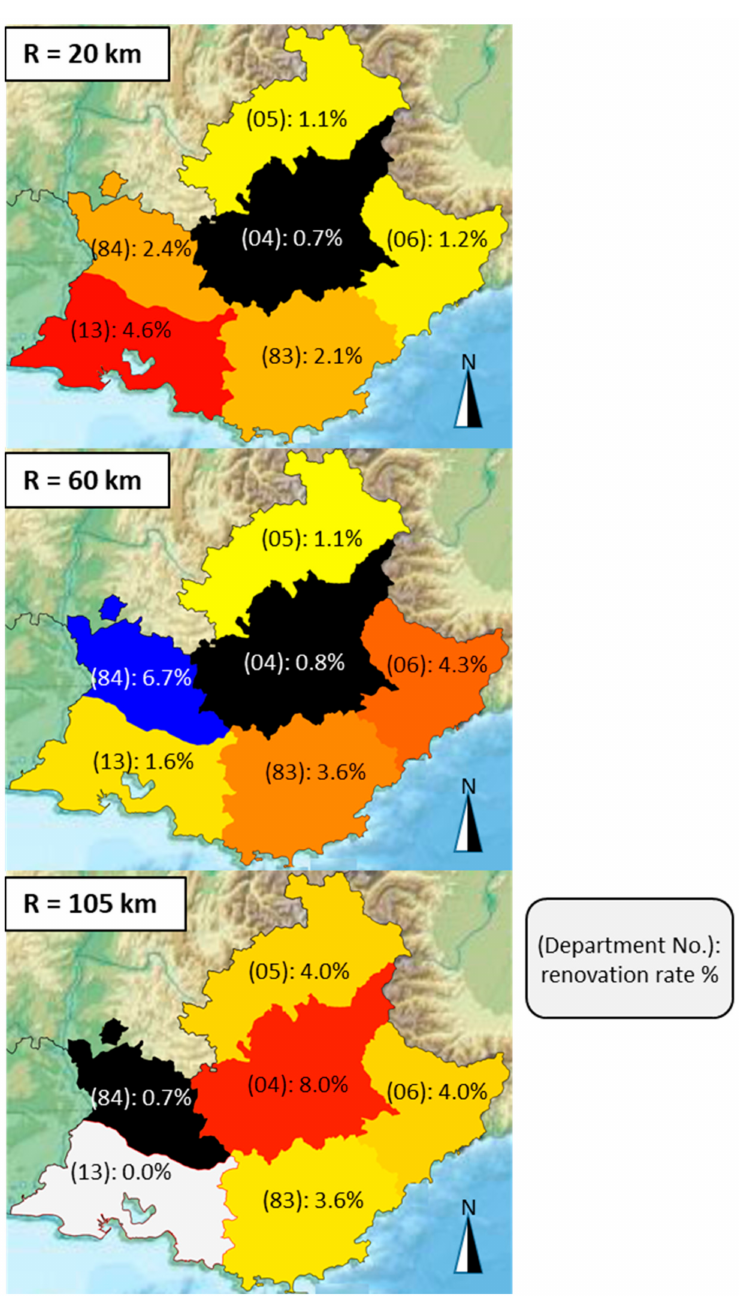
Figure 7. Distribution hypotheses for the renovation rate of each Department as a function of the simultaneous search radius for gravel and asphalt suppliers. Source: this